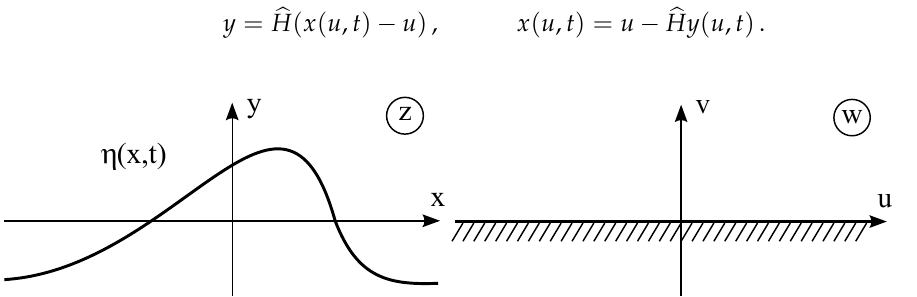
Figure 5. Physical plane z ( left ). Conformal plane w ( right